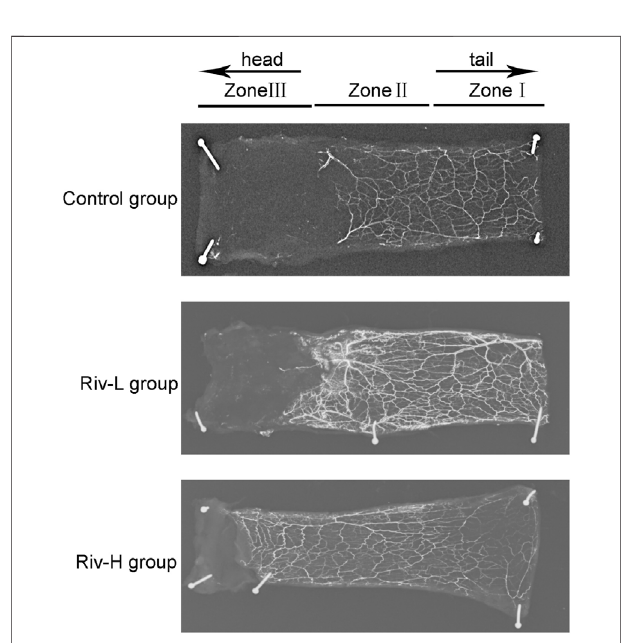
FIGURE 7 | Lead oxide dissolved in gelatin was injected into the blood vessels of rats for X-ray imaging. Rivastigmine signi fi cantly enhanced construction of the capillary network. ** p <